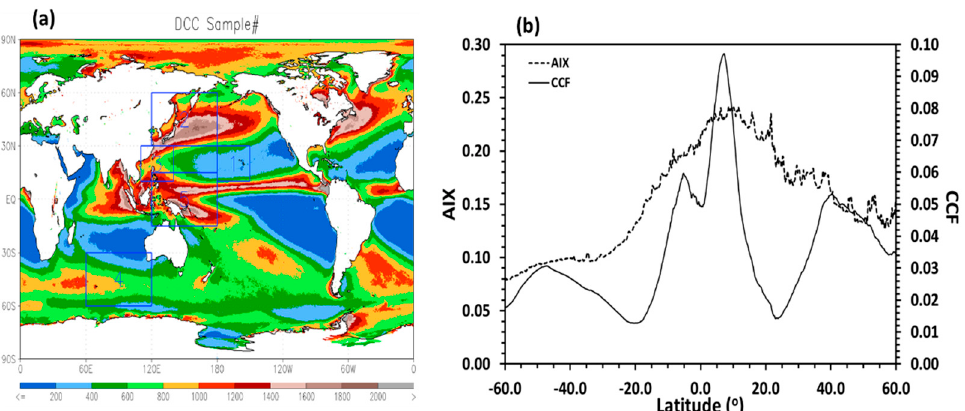
Figure 3. ( a ) Global distribution of total DCC sample numbers used to compute the climatology of six DCC cloud variables in Figure 2, ( b ) zonally averaged climatology of AIX and CCF. Five regions listed in Table 1 are also marked in ( a ) with 5 blue boxs.